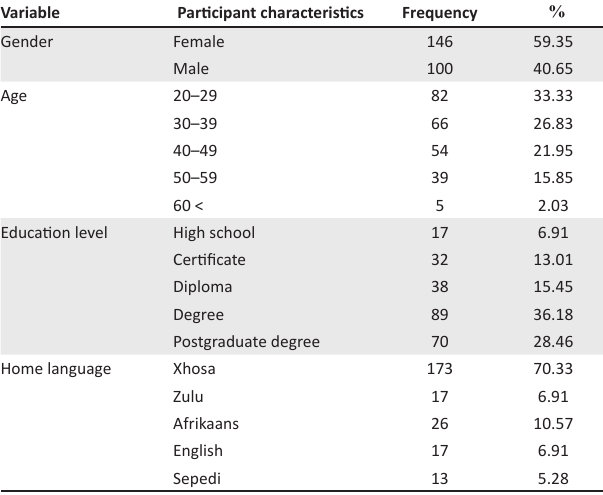
TABLE 1: Demographic characteristics of the